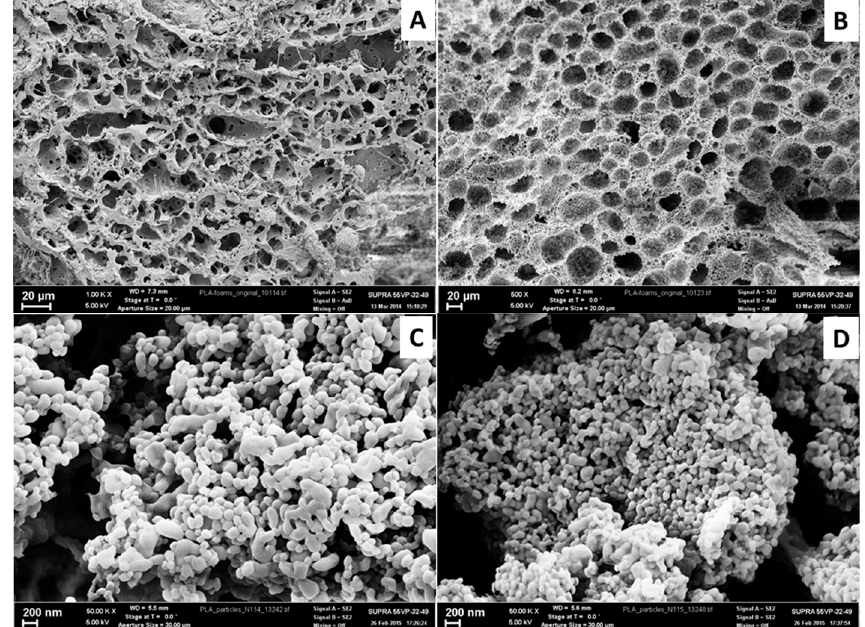
Figure 1. Morphology of polyester-based materials visualized by scanning electron microscope (SEM): ( A ) poly(lactic acid) (PLA) and ( B ) poly( ε -caprolactone) (PCL) supermacroporous matrix; ( C ) PLA and ( D ) PCL nanoparticles.